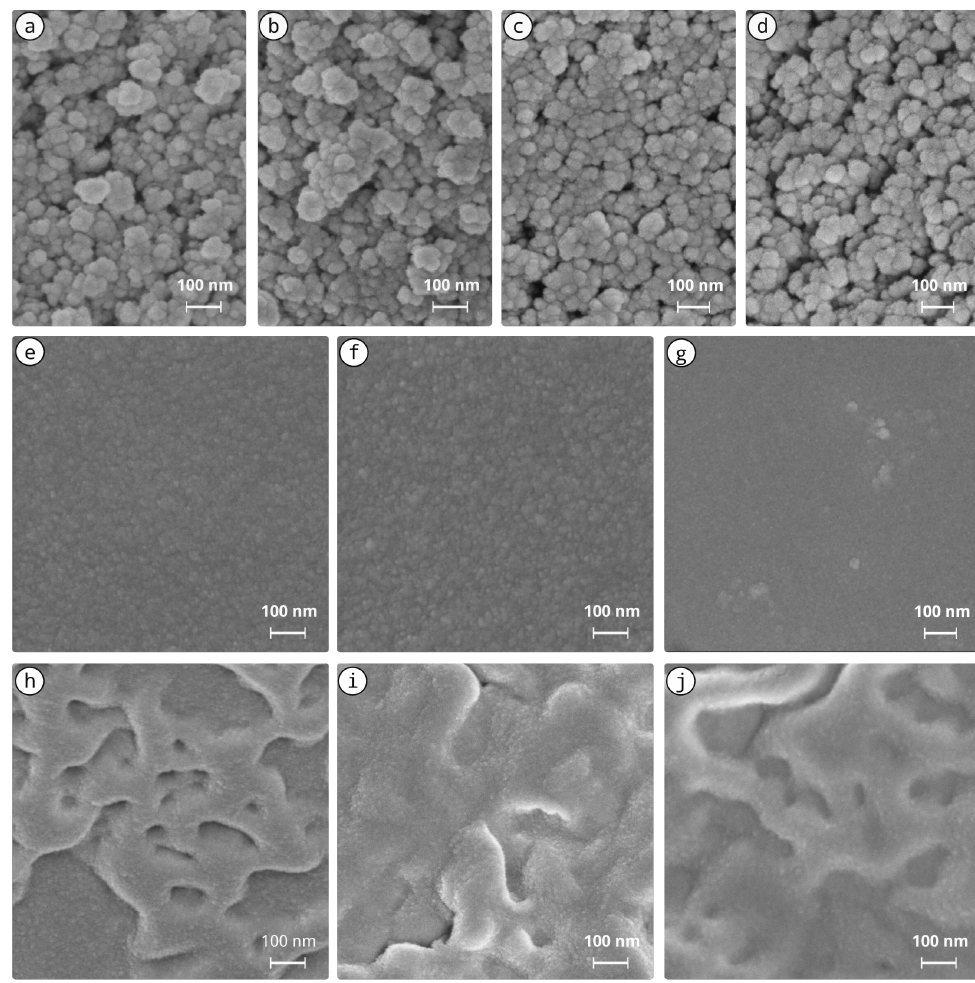
Figure 2. Exemplary scanning electron micrographs of the nanocomposite xerogels produced under alkaline and acid catalysis. ( a ) NH 3 -ref; ( b ) NH 3 :nHAp; ( c ) Oct-ref; ( d ) Oct-nHAp; ( e ) HCl-ref; ( f ) HCl:nHAp; ( g ) HCl:nSiO 2 ; ( h ) HCl:PEG-ref; ( i ) HCl:PEG:nHAp; ( j ) HCl:PEG:nSiO 2